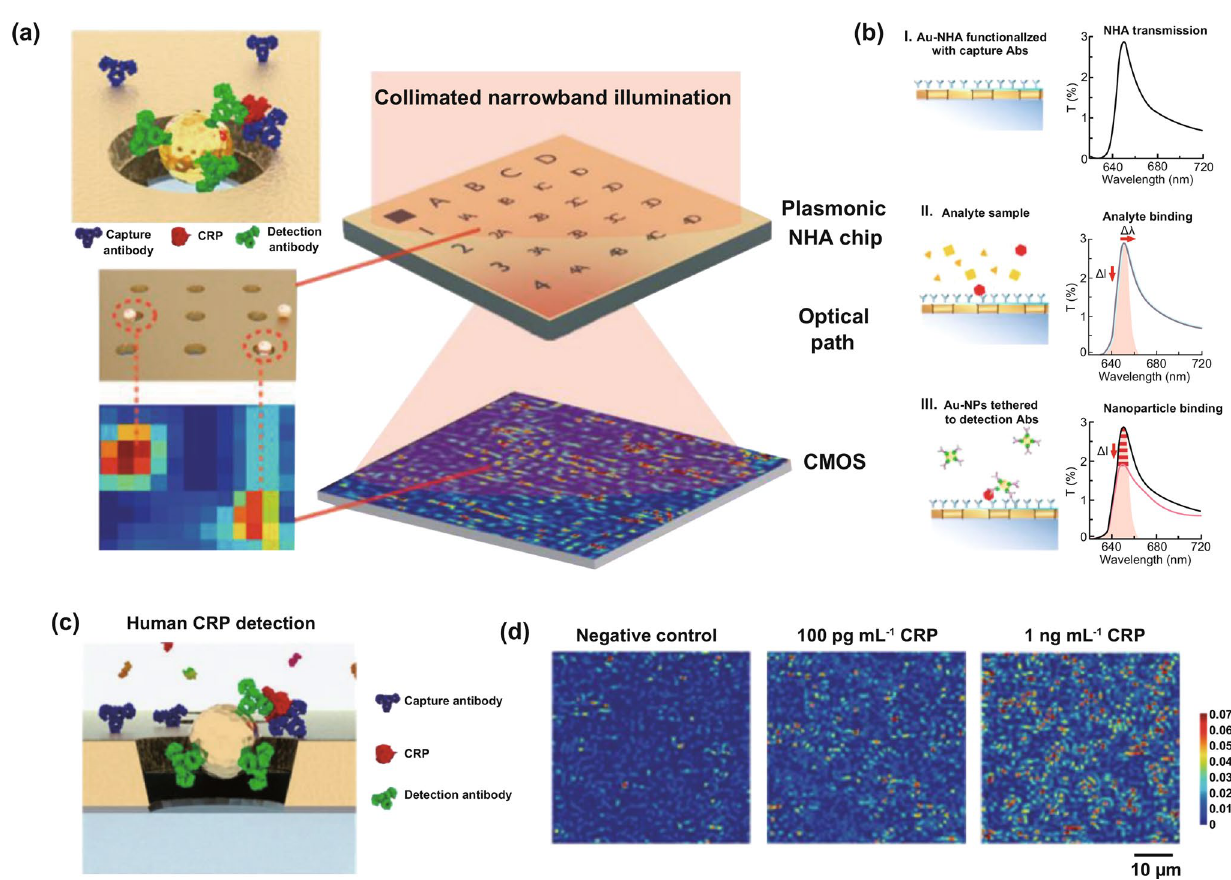
Fig. 5 Nanoparticle-enhanced plasmonic biosensor for the rapid and precise detection of CRP. a Design and detected mechanisms of the nano- particle-enhanced plasmonic imager. b The EOT peak variance of Au-NHAs in different steps during detection. c Human CRP sandwich assay. d Different concentrations of CRP can be visually distinguished on plasmonic imaging. Reproduced with permission from Ref. [140]. Copyright 2018 American Chemical